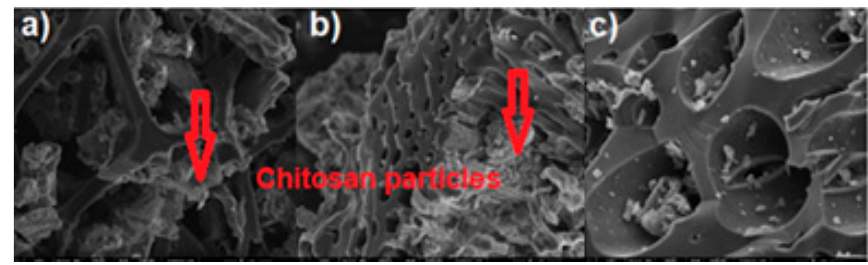
Figure 2. SEM images of ( a ) BC-CS 1-1, ( b ) BC-CS 2-1, ( c ) BC-CS 4-1 at 5000× magnification.